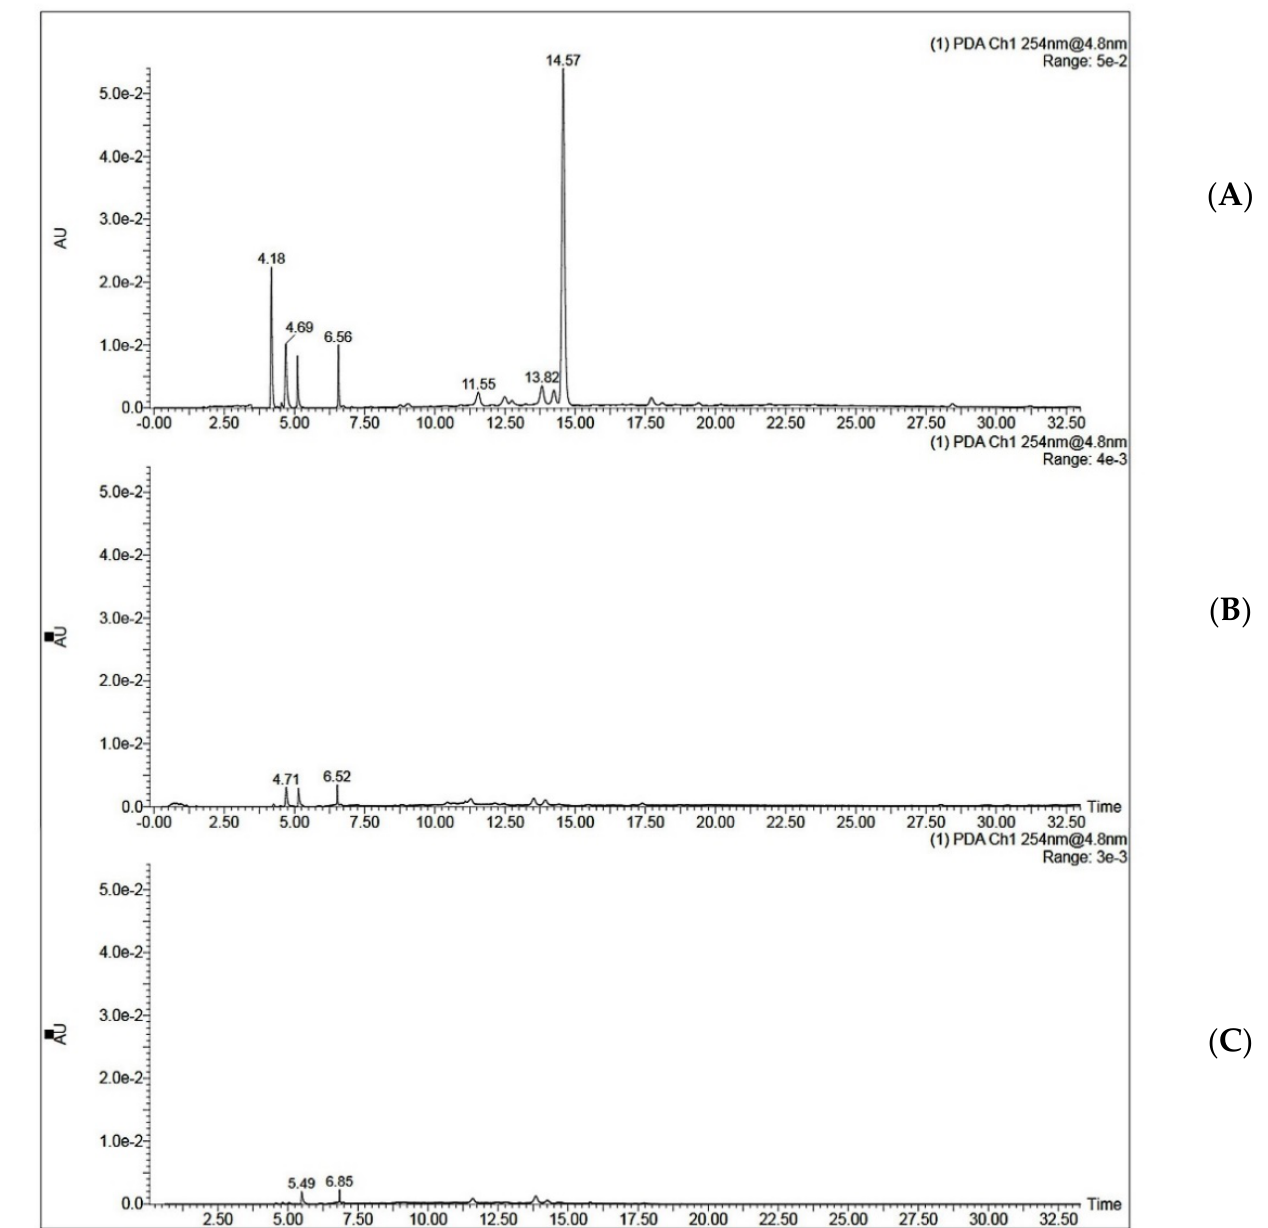
Figure 10. UV chromatograms of QA ( A ) in 0.25 µg/mL coffee extract dissolved in ethanol: water (97:3 v / v ) before loading to MISPE C, ( B ) the elution fraction obtained from MISPE procedure, ( C ) the elution fraction obtained from NISPE procedure.